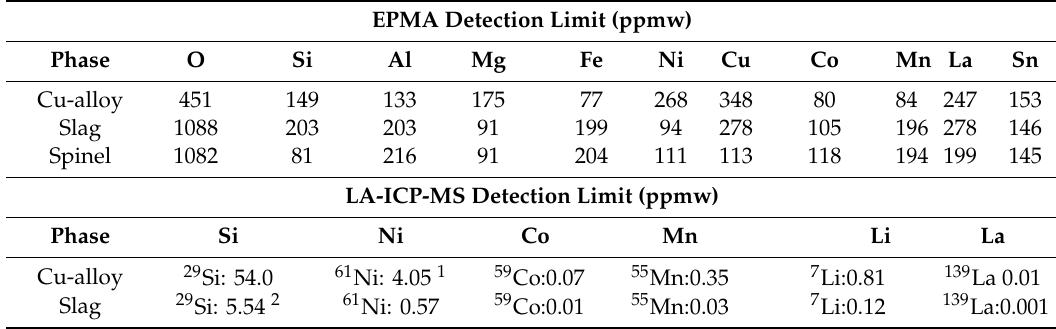
Table 3. The elemental / isotopic detection limits of electron probe microanalysis (EPMA) and laser ablation-inductively coupled plasma-mass spectrometry (LA-ICP-MS) for each phase analyzed. (ppmw = parts per million by weight.).